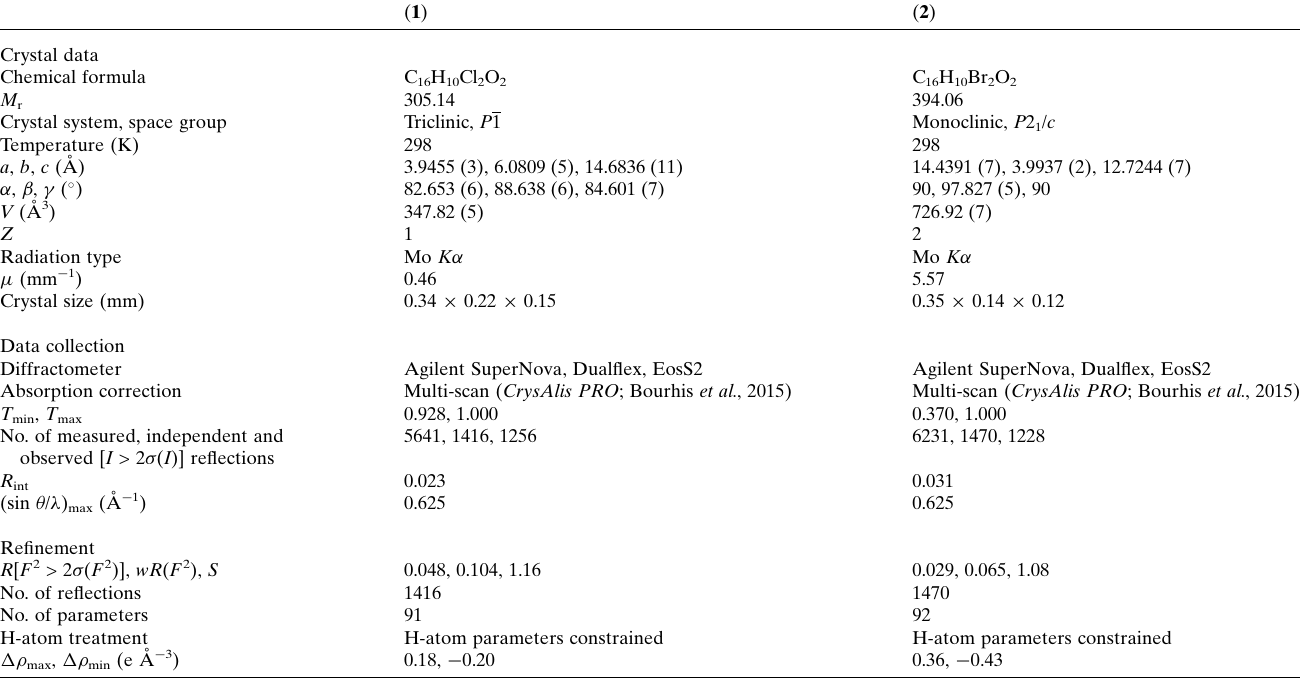
Crystal data Chemical